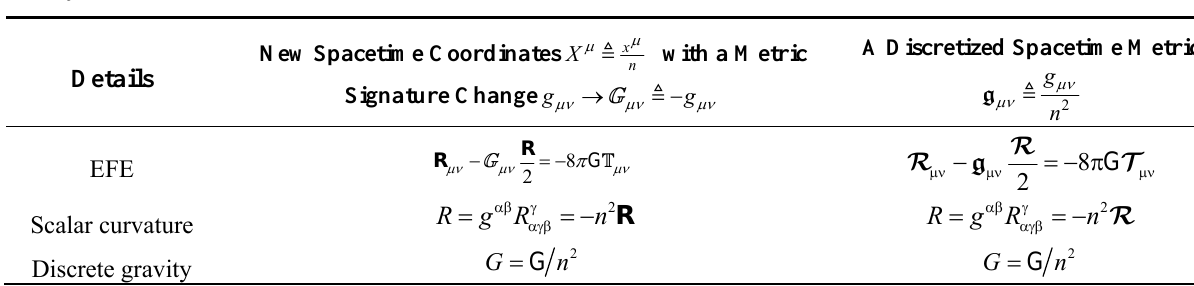
Table 2. Main differences between the two independent discrete solutions obtained for ξ = ±2 π i.